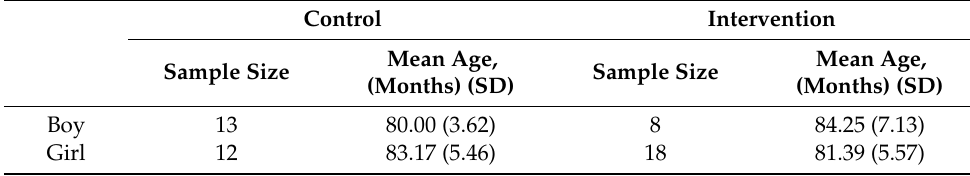
Figure 1. CONSORT diagram: Number of participants in the control and intervention group at each timepoint. Table 1. Descriptive statistics of the control and intervention